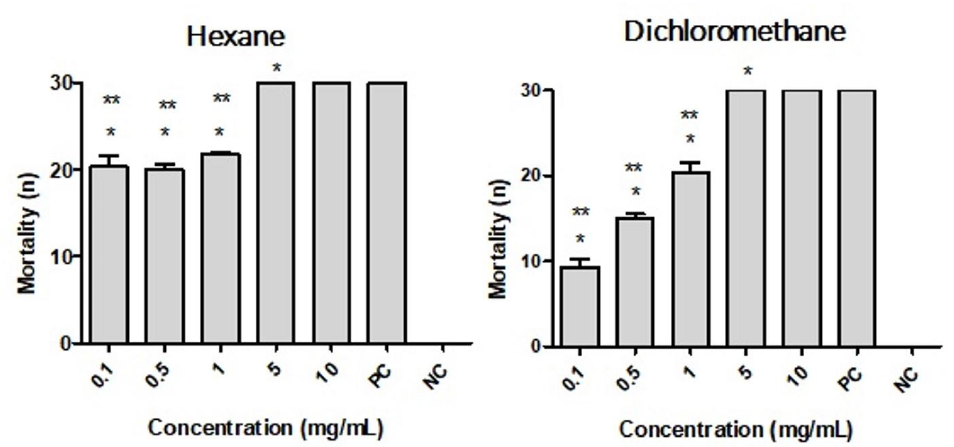
Figure 2. Ovicidal activity of different concentrations of fractions of Helicteres velutina on Aedes aegypti eggs after 25 days. PC = Positive Control, NC = Negative Control. (*) Results significantly different from negative control. (**) Results significantly different from positive control.